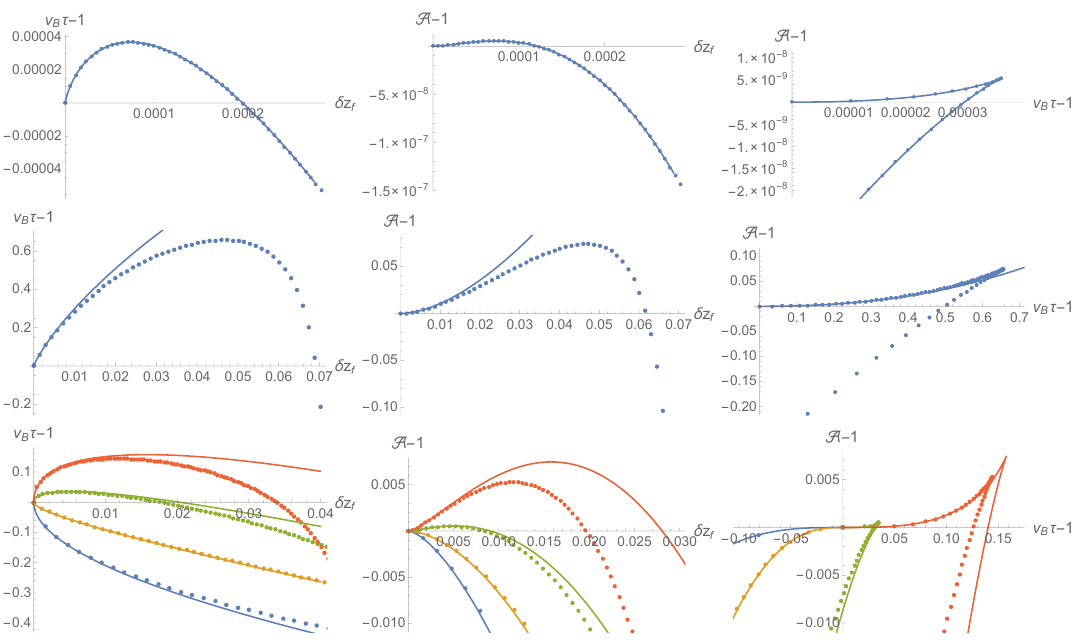
Figure 10. Comparison of the (cid:14)z f expansion (solid curve) (4.29) and (4.31) (combined with the series expansion of (4.23)) with the numerical evaluation of (4.22) (data points). For di(cid:11)erent black branes from left to write we plot v B (cid:28) 1 and 1 as a function of (cid:14)z f , and (cid:12)nally the parametric (cid:0) A (cid:0) curve ( v B (cid:28) 1 ; 1) showing the cuspy behavior seen on (cid:12)gure 9, but magni(cid:12)ed. Top: d = 3 (cid:0) A (cid:0) Schwarzschild black brane, which was the primary example discussed in this section. Note that the extremely small values on the axes is the reason why we were not able to see discontinuous saturation 1 on (cid:12)gures 6 and 9. The curve plotted on the (cid:12)rst plot is v B (cid:28) 1 = (cid:14)z f log (cid:14)z f 4 : 2598 (cid:14)z f . 2 (cid:0) (cid:0) (cid:0) The zero of this curve is hence approximately at (cid:14)z f = e (cid:0) 8 : 52 explaining the small scale of the graph. The rest of the curves are easy to obtain from this formula. There is a perfect agreement between the expansion and the numerical evaluation of the integrals (4.22). Middle: d = 3 RN 13 black brane with q = 3 = 4, for which v B (cid:28) 1 = (cid:14)z f log (cid:14)z f + 0 : 03822 (cid:14)z f + : : : . We see that 2 (cid:0) (cid:0) the scale of the curves is a lot bigger than what we got for the Schwarzschild case, and the series expansion only matches the numerical data for small values of (cid:14)z f . Bottom: d = 4 RN black branes with q = 0 ; 1 = 2 ; 2 = 3 ; 3 = 4 plotted with blue, orange, green, and red respectively. The values of c 4 de(cid:12)ned in (4.31) are c 4 = 1 : 9955 ; 0 : 5164 ; 1 : 0005 ; 2 : 5126 respectively, and the sign of c 4 (cid:0) (cid:0) determines whether saturation is continuous or discontinuous: for q = 0 ; 1 = 2 we get continuous saturation, while the other two cases lead to discontinuity. The solid curves include the subleading term from (4.31) as